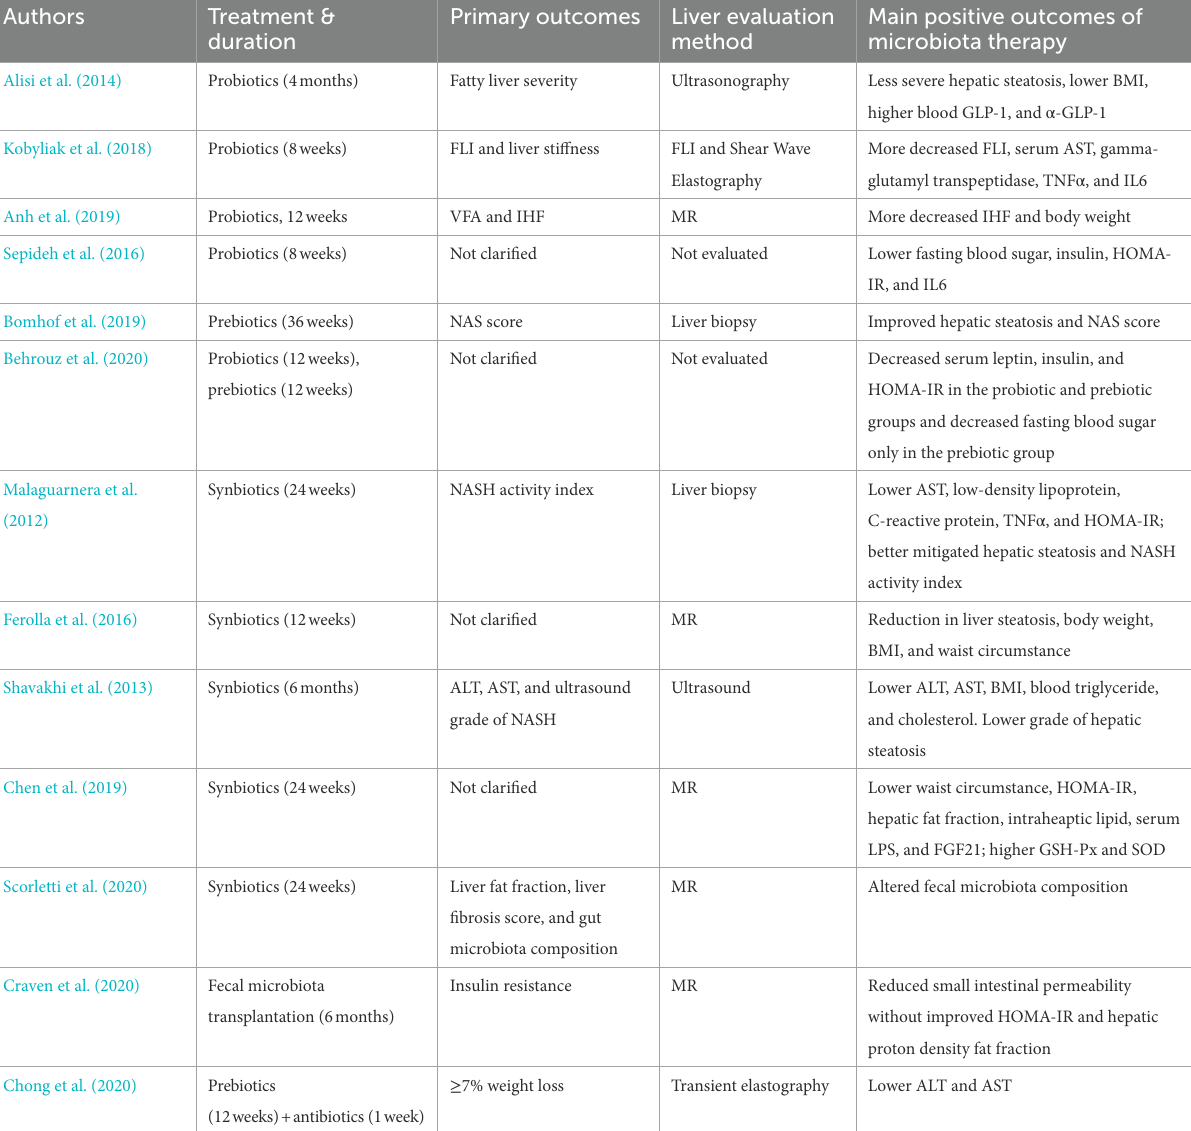
TABLE 2 Primary outcomes, liver evaluation method, and main positive outcomes of randomized clinical trials of gut microbiota therapy in nonalcoholic fatty liver